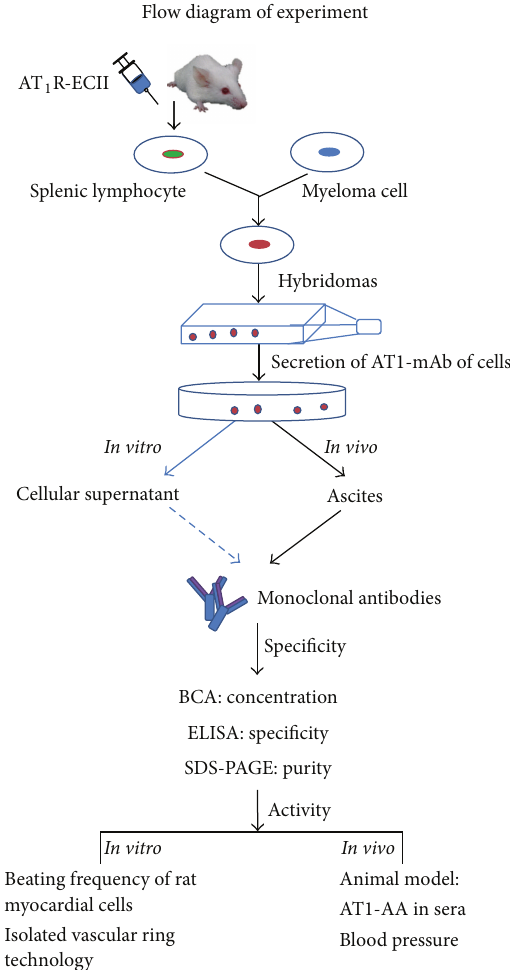
Figure 6: Flowchart of experimental procedures.